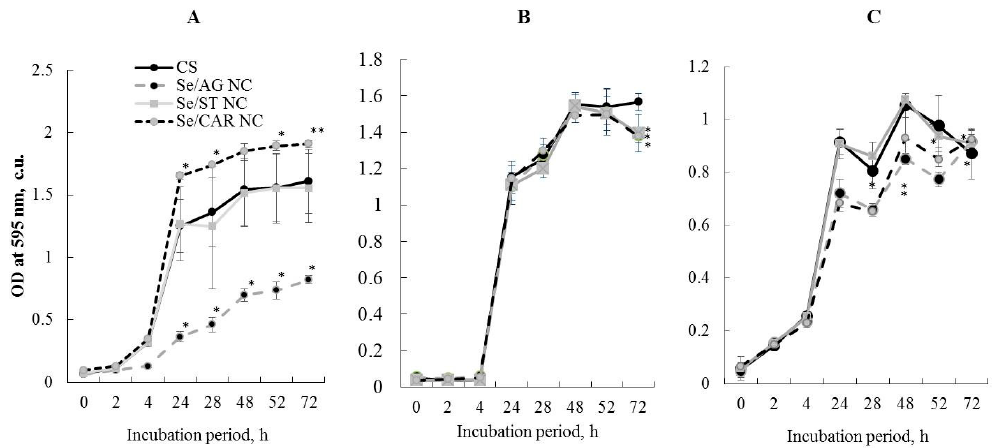
Figure 8. Effect of the Se NC treatments (with 105.57 µg/mL for Se/AG NC, 428.08 µg/mL for Se/ST NC, and 170.30 µg/mL for Se/CAR NC, which corresponds to the Se concentration of 6.25 µg/mL in the final solution) on the growth dynamics of rhizosphere bacteria A. guillouiae ( A ), R. erythropolis ( B ), and P. oryzihabitans ( C ). CS—control samples; * p < 0.01, ** p < 0.05 (in comparison with CS at each respective time point) based on 9 independent observations per each Se NC, control and